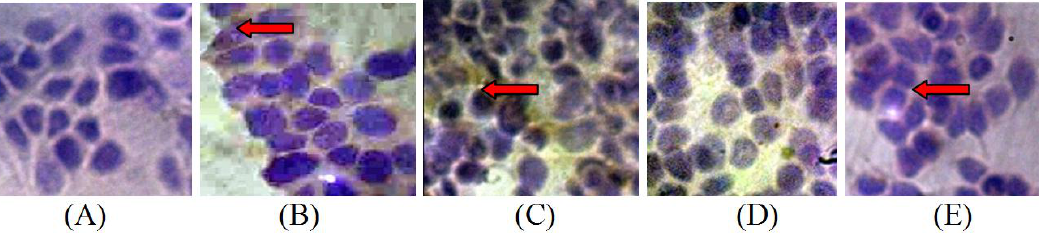
Figure 4. Effect of Hesperitin on P-gp Expression in MCF-7/DOX cells. MCF-7/DOX cells cultured in 24-well plates with density 1 × 10 5 cells per well on coverslip. (A) Control without antibody; (B) control with antibody; (C) cells treated with doxorubicin 230 nM, (D) 95 μM hesperetin, and (E) combination doxorubicine 230 nM and hesperetin 95 μM. Pgp expression located in cell membrane showed brown color (red